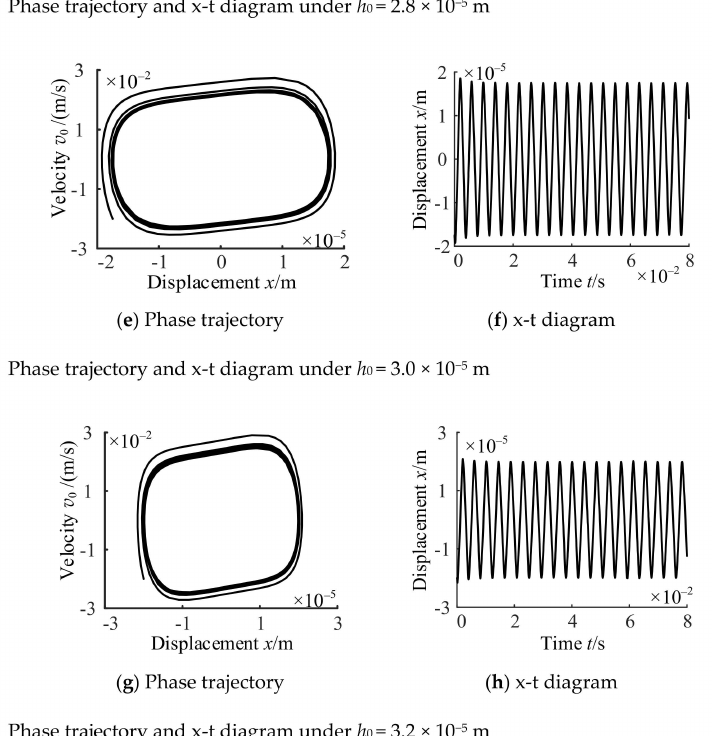
Figure 9. Phase trajectory and x-t diagram. According to Figure 9, when h 0 increases from 2.6 × 10 − 5 m to 3.2 × 10 − 5 m, vibration amplitude increases from 1.2 × 10 − 5 m to 2.0 × 10 − 5 m and the maximum vibration